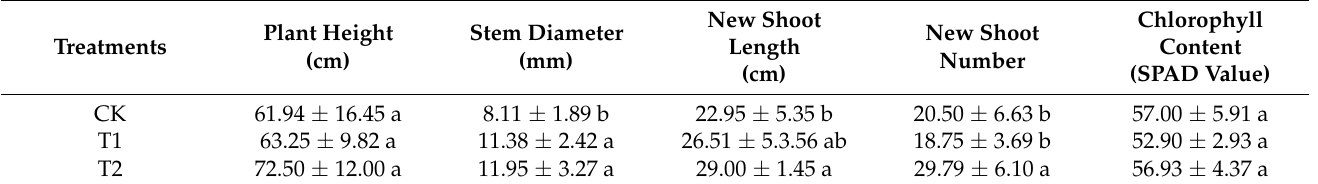
Table 1. Effects of different nutrition treatments on the growth of ‘Misty’ in the plant factory with artificial lighting.